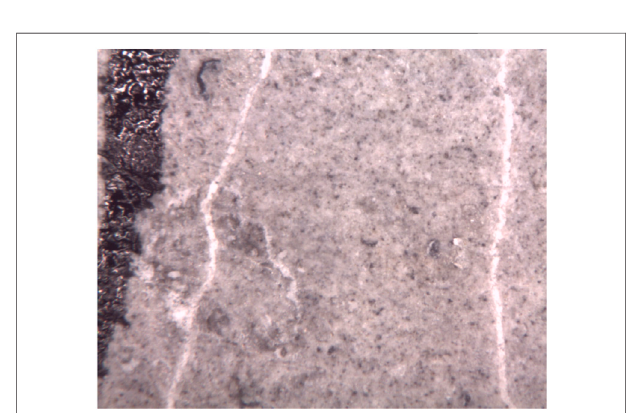
FIGURE 12 | Self-healing CR2-0.4-0.5% specimen surface after 7 wet – dry conditioning.